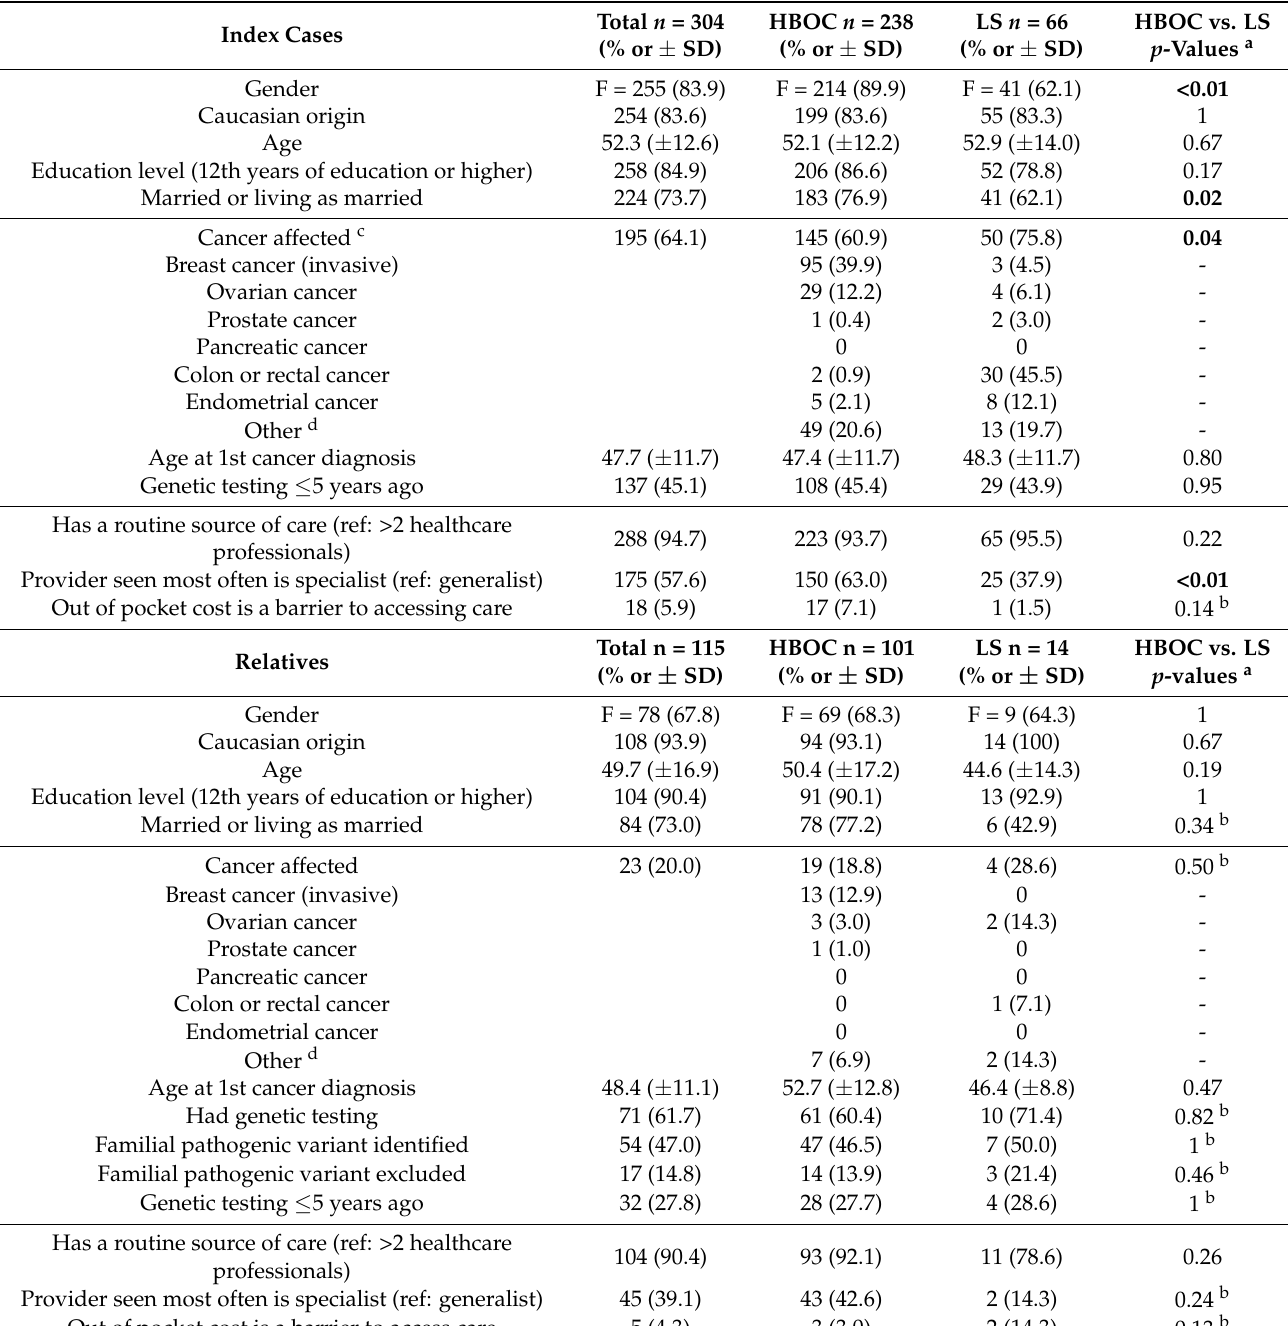
Table 1. Demographic and clinical characteristics of index cases and relatives by